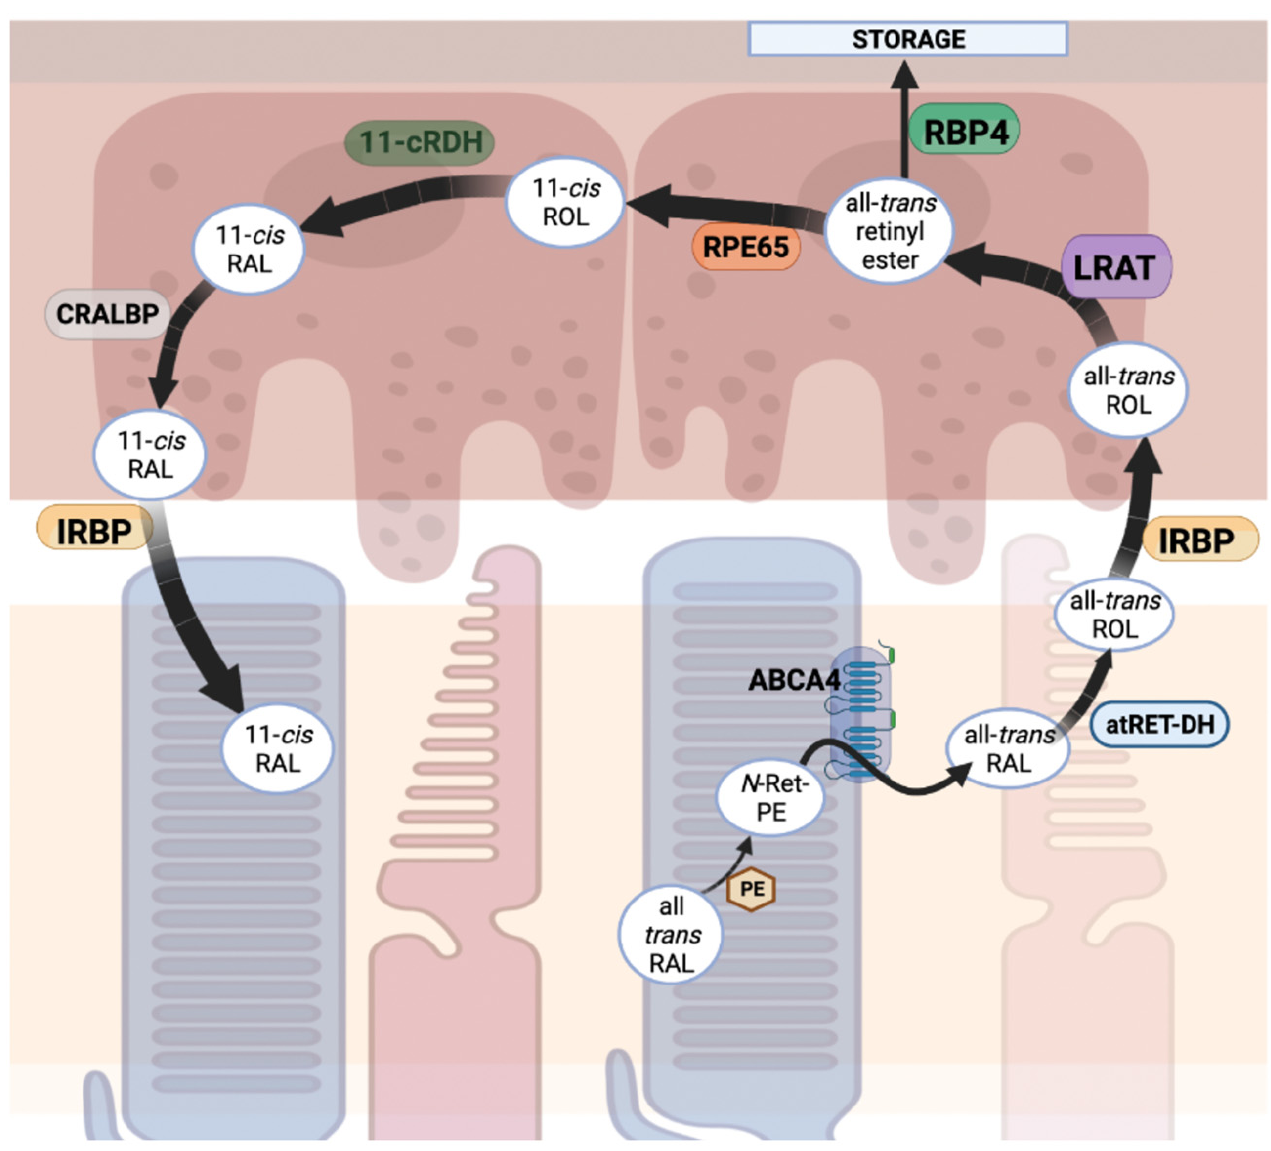
Figure 6. Diagram of the visual cycle proteins. The primary role of the visual cycle is the replenish- ment of 11- cis retinal (11- cis RAL) in photoreceptor cells via the re-isomerization of all- trans retinal (all- trans RAL). Once the all- trans retinal is cleaved from rhodopsin during phototransduction, it reacts with phosphatidylethanolamine (PE) to form N -retinylidene-phosphatidylethanolamine ( N - Ret-PE), which binds the flippase ABCA4, resulting in a confirmational change that releases all- trans retinal into the cytoplasmic leaflet of the disc membrane. All- trans retinal is then reduced by all- trans retinol dehydrogenase (atRET-DH), forming all- trans retinol (all- trans ROL). All- trans retinol is trafficked by the retinal-binding protein IRBP from the photoreceptor outer segment to the RPE. Once in the RPE, the acyl transferase LRAT reacts an acyl group with all- trans retinol to form an all- trans retinyl ester. All- trans retinyl esters are a nontoxic storage form of retinal, which may be traf- ficked for storage by another retinal-binding protein RBP4. The rate-limiting step of the visual cycle is the isomerization of the all- trans retinyl ester to form 11 cis -retinol (11- cis ROL), in which 11- cis retinol dehydrogenase (11-cRDH) then oxidizes 11- cis retinol to form 11- cis retinal. 11- cis retinal is then chaperoned by the retinal-binding protein CRALBP to protect it from further isomerization or esterification. Finally, 11- cis retinal is trafficked from the RPE to the outer segment of photoreceptor discs, where it may bind opsin to regenerate functional rhodopsin. As all- trans retinyl esters are being formed along the smooth endoplasmic reticulum of RPE cells by LRAT; the trans isoform is then isomerized via retinoid isomerohydrolase retinal pigment epithelium 65 kDa (RPE65). RPE65 is primarily expressed in RPE cells and